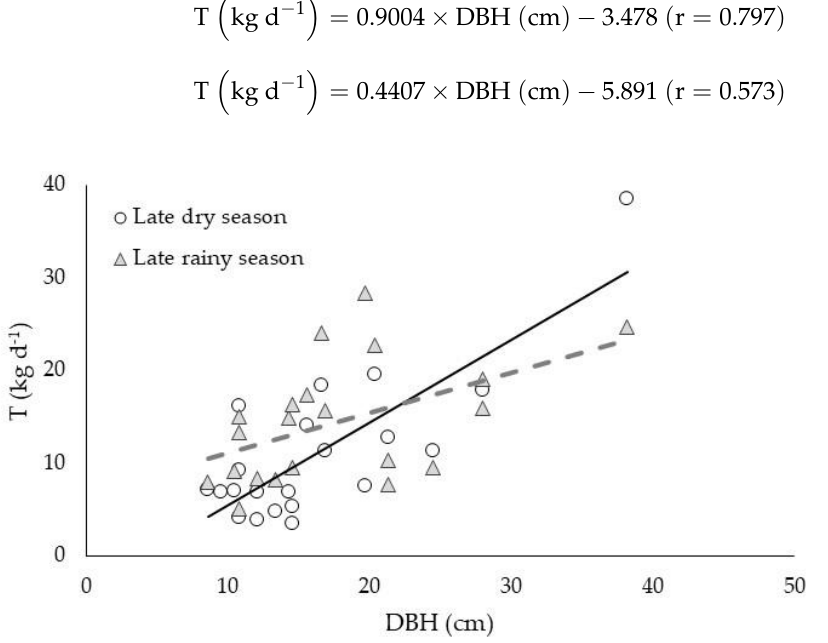
Figure 2. Allometric relationship of diameter at breast height (DBH) versus daily mean transpiration (T) estimates (kg water d –1 ). Late dry season (solid line, open circles) correspond to March–April; late rainy season (dashed line, closed triangles), to September–October.